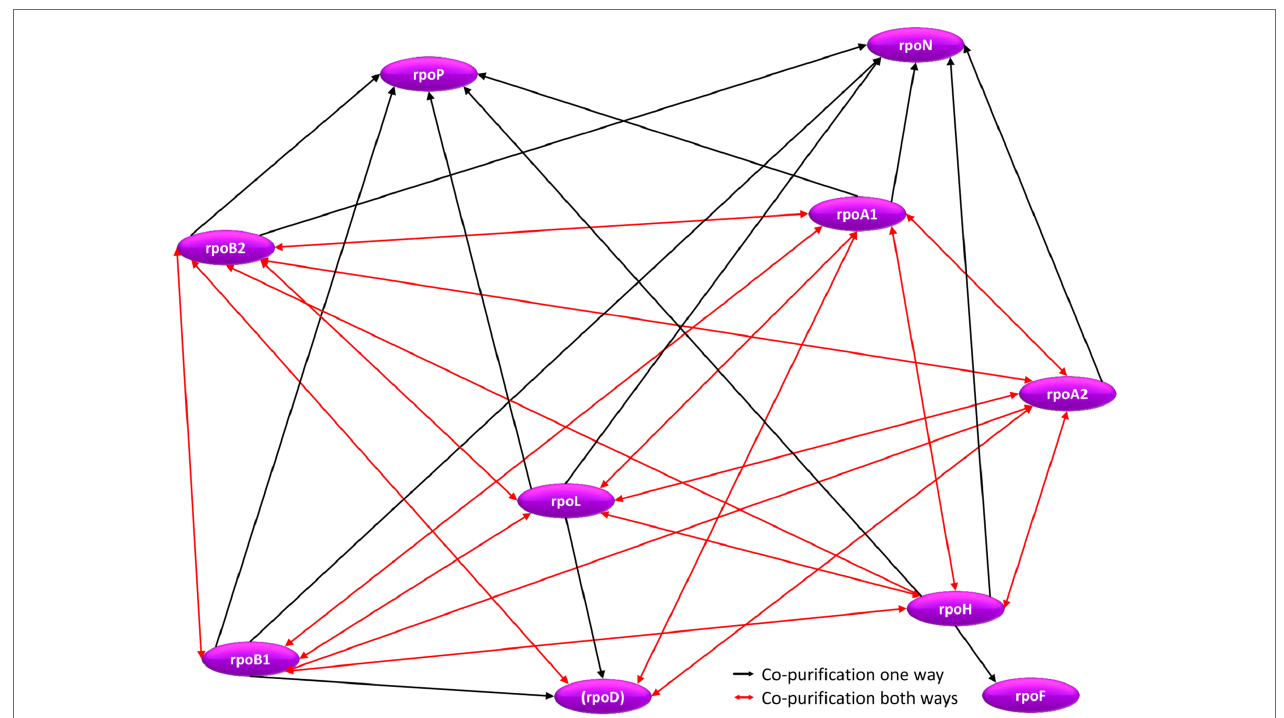
FIGURE 7 | Schematic overview of the internal RNA polymerase subunit interaction network. Red arrows denote reciprocal co-purification, while black arrows depict one-directional